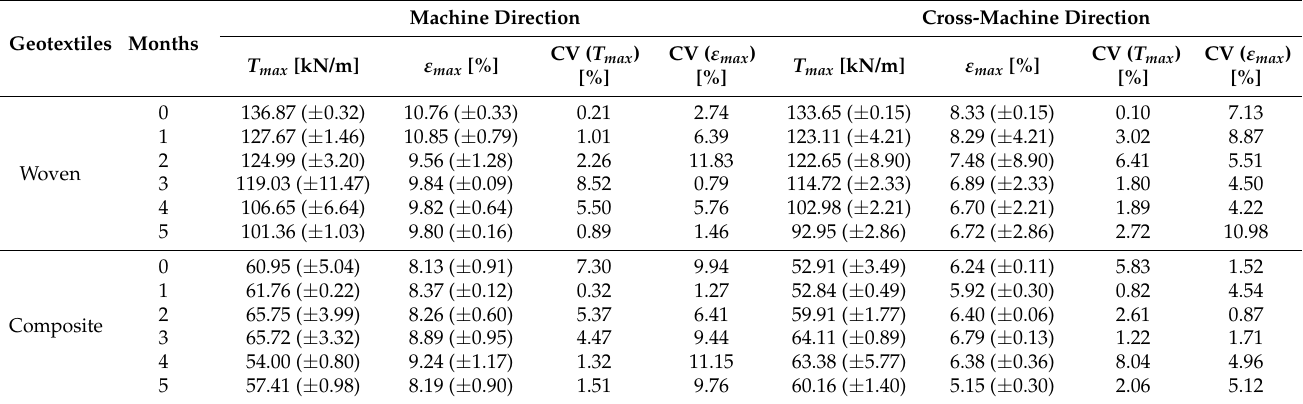
Table 2. Tensile properties of woven and composite geotextiles at various months of UV